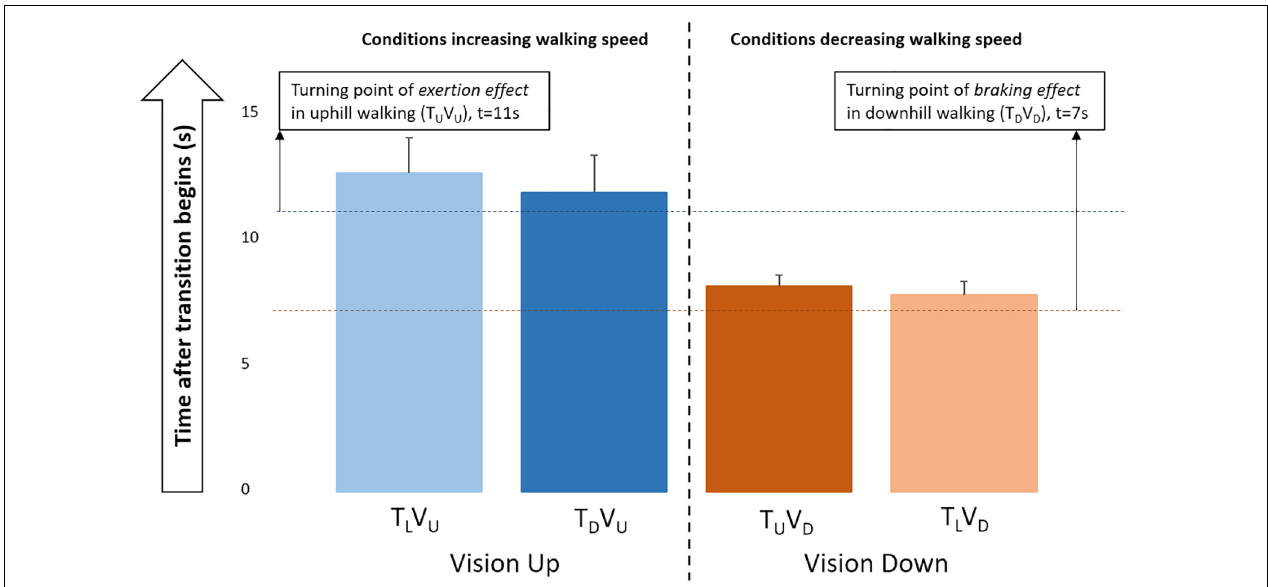
FIGURE 5 | Temporary adaptation of walking speed during initial response. Time of maximal change in conditions increasing (left) and decreasing (right) walking speed in the first 20 s post-transition (see Figure 2 , rightmost column). Error bars represent standard error. Dashed horizontal lines mark the turning points when participants begin countering gravitational deceleration (increase exertion) in congruent uphill walking (11 s) or begin yielding to gravitational acceleration (decrease braking) in congruent downhill walking (7 s). Thus, humans exercise braking to maintain walking stability with a downhill shift sooner than they apply exertion to attain stability with an uphill shift. Critically, this pattern was evident even in conditions of incongruence between visual and physical cues, suggesting that visual cues predominate over physical cues for perception of environmental